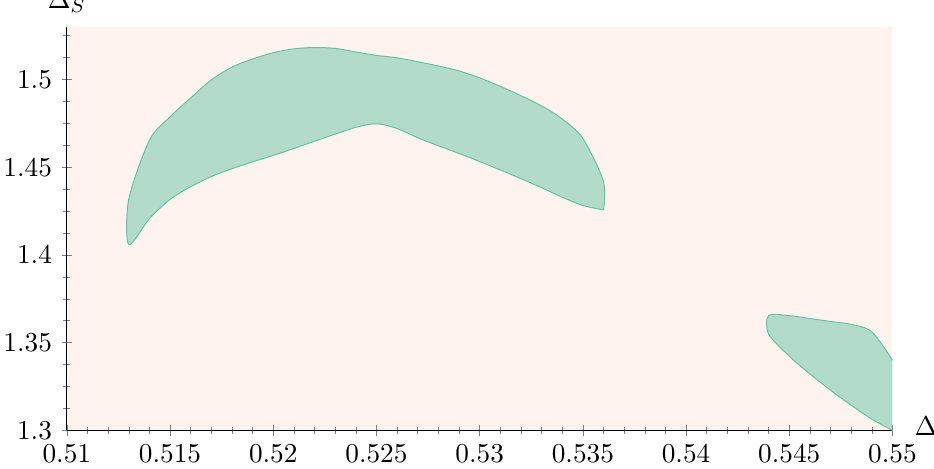
Figure 13: Allowed region (in green) for the O sumptions